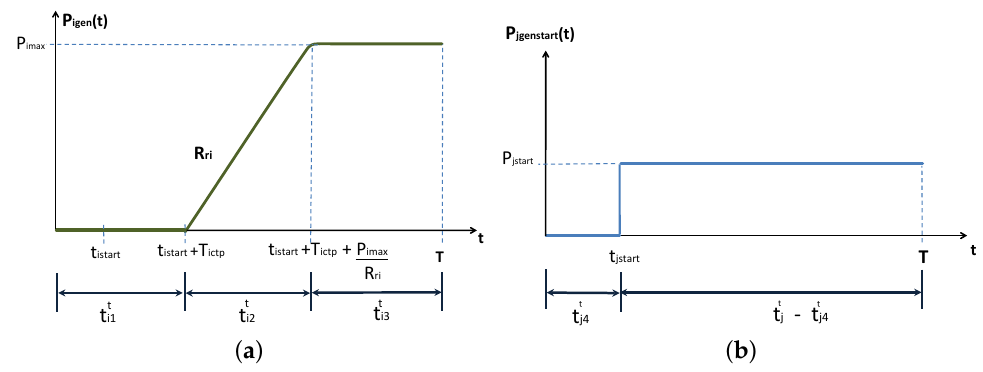
Figure 3. Characterization of conventional generators: ( a ) capacity curves for BS and NBS units; ( b ) starting curve of an NBS